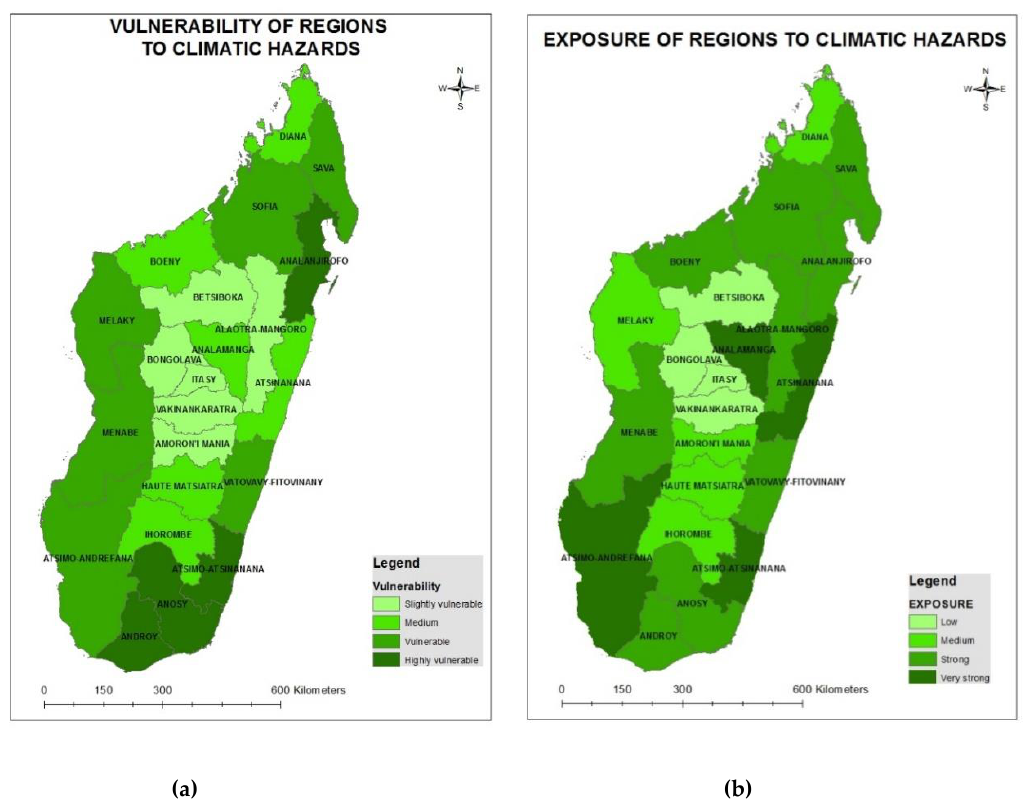
Figure 7. Vulnerability ( a ) and exposure ( b ) of regions in Madagascar to climate Figure 7 . Vulnerability ( a ) and exposure ( b ) of regions in Madagascar to climate hazards.